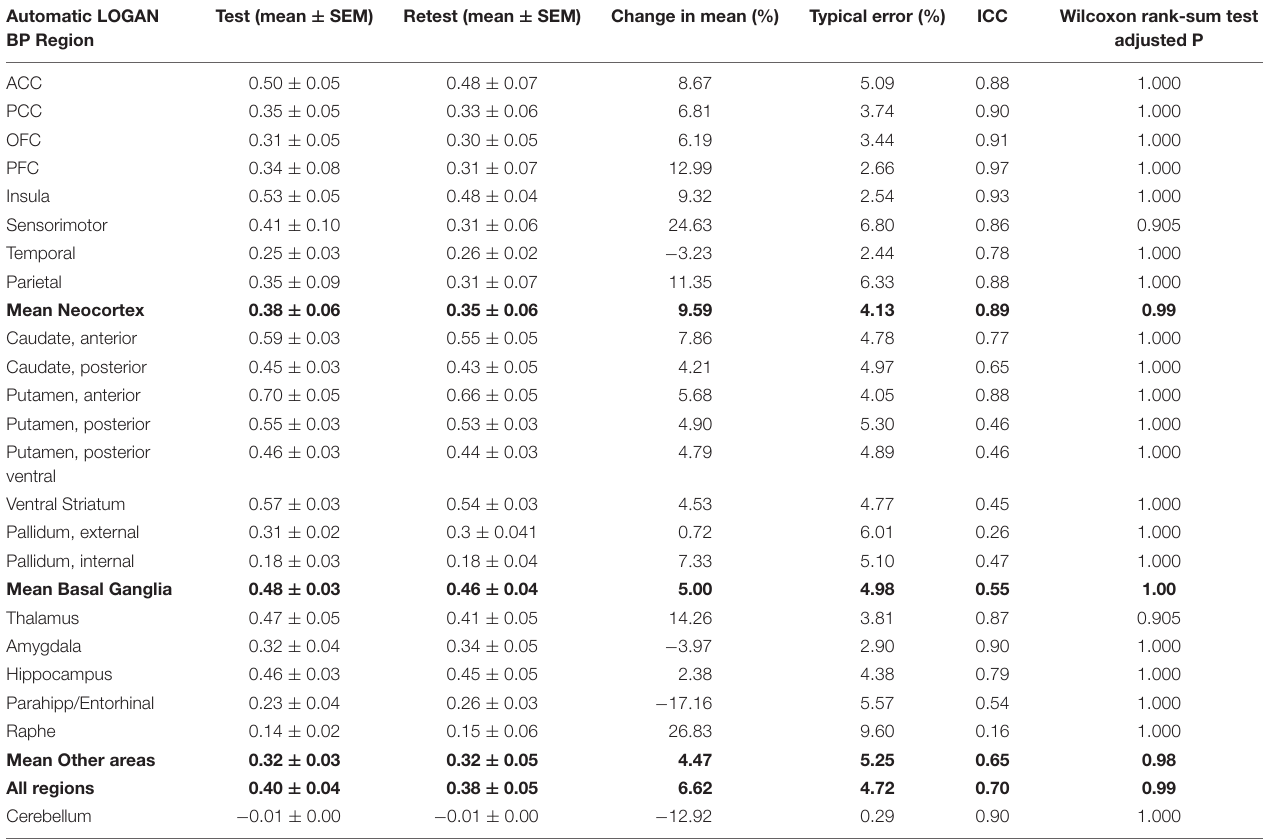
TABLE 1 | Test–retest characteristics of BP ND computed with automatic spatial registration and the Logan model. Automatic LOGAN BP